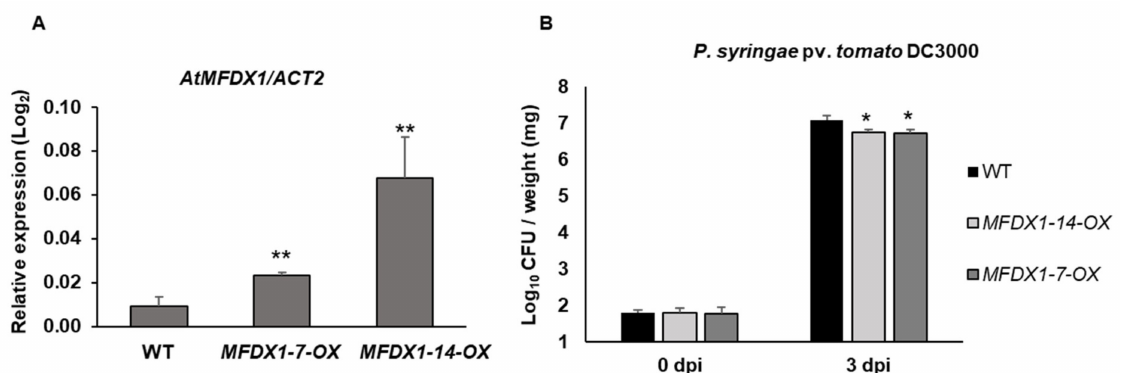
Figure 3. Arabidopsis AtMFDX1 overexpressor lines are less susceptible to the host pathogen P. syringae pv. tomato DC3000: ( A ) Relative expression of the AtMFDX1 gene in the Arabidopsis WT (Col-0) and AtMFDX1 overexpression lines. Total RNA was isolated from 5-week-old Arabidopsis plants and was subject to RT-qPCR. The expression level was normalized to the AtACT2 gene. Histograms represent means of four biological replicates. Error bars represent standard error. Asterisks represent statistical significance according to student’s t test (** p -value < 0.01). All experiments were repeated two times with similar results. ( B ) Quantification of host pathogen multiplication in AtMFDX1 overexpressor lines. Four-week-old Arabidopsis WT and AtMFDX1 overexpressor lines ( MFDX1-14-OX and MFDX1-7-OX ) were flood inoculated with host pathogen P. syringae pv. tomato DC3000 at 8 × 10 4 CFU/mL. Samples (rosettes) were collected at 0 dpi and 3 dpi for bacterial quantification. Histograms represent means of four biological replicates. Error bars indicate standard error. Asterisks indicate significant differences compared to the WT according to Student’s t test (* p -value < 0.05). hpi, hours post infection; dpi, days post